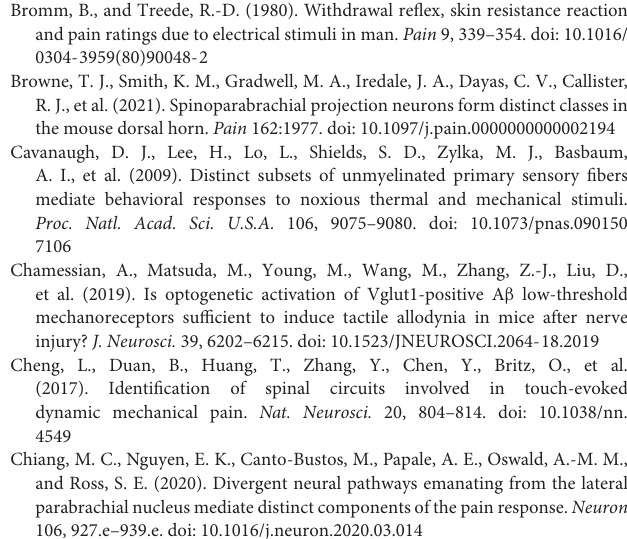
Supplementary Figure 1 | The ChR2-EYFP + neurons overlapped with Mrgprd ( ISH ). (A) Representative images of co-expression of ChR2-EYFP (green) with Mrgprd + neurons identified by in situ hybridization (red) in DRG. Scale bar, 200 µ m. Supplementary Figure 2 | Yellow light cannot evoke any nocifensive behaviors in naïve Mrgprd-ChR2 mice or TRPV1-ChR2 mice. (A,B) Nocifensive behaviors evoked by hindpaw plantar yellow light stimulation at 20 mW/mm 2 with different frequencies (2, 5, 10 Hz) in naïve Mrgprd-ChR2 mice ( n = 6 animals) and TRPV1-ChR2 mice ( n = 6 animals). Data are presented as mean ± SEM. Supplementary Figure 3 | SNI induces mechanical and thermal hypersensitivity. (A) SNI-induced static allodynia to von Frey filaments ( n = 7 animals per group). (B) SNI-induced dynamic allodynia to brush ( n = 7 animals per group). (C) SNI-induced changes in withdrawal latency to heat ( n = 7 animals per group). Data are presented as mean ± SEM. “NS,” no significance, ∗ p < 0.05, ∗∗ p < 0.01, ∗∗∗ p < 0.001, ∗∗∗∗ p < 0.0001. Two-way repeated-measures ANOVA with holm-sidak test for (A–C) . Supplementary Figure 4 | Temperature measurement following sustained blue light illumination. (A) Time course of blue light-induced changes in temperature following sustained blue light illumination (10 min, 10 Hz, 20 mW/mm 2 ) with contact or 1 cm away from the meter. Supplementary Figure 5 | SNI did not change the distribution of Mrgprd + afferents in the spinal cord, density of neurons expressing Mrgprd or proportion of ChR2-EYFP + neurons expressing Mrgprd . (A,B) Representative images of ChR2-EYFP (green) distribution and colocalization with IB4 (red)/CGRP (blue) in the lumbar spinal cord in naïve Mrgprd-ChR2 mice and SNI Mrgprd-ChR2 mice. Scale bar, 100 µ m. (C) Statistical data for the density of Mrgprd + neurons identified by in situ hybridization in DRG sections from naïve Mrgprd-ChR2 mice and SNI Mrgprd-ChR2 mice ( n = 3 animals per group). (D) Statistical data for the percent of Mrgprd + cells that co-expressed with ChR2-EYFP (left) and the percent of ChR2-EYFP + neurons that co-expressed with Mrgprd (right) in DRG from naïve Mrgprd-ChR2 mice and SNI Mrgprd-ChR2 mice ( n = 3 animals per group). Data are presented as mean ± SEM. “NS,” no significance. Unpaired Student’s two-tailed t -test for (C,D)